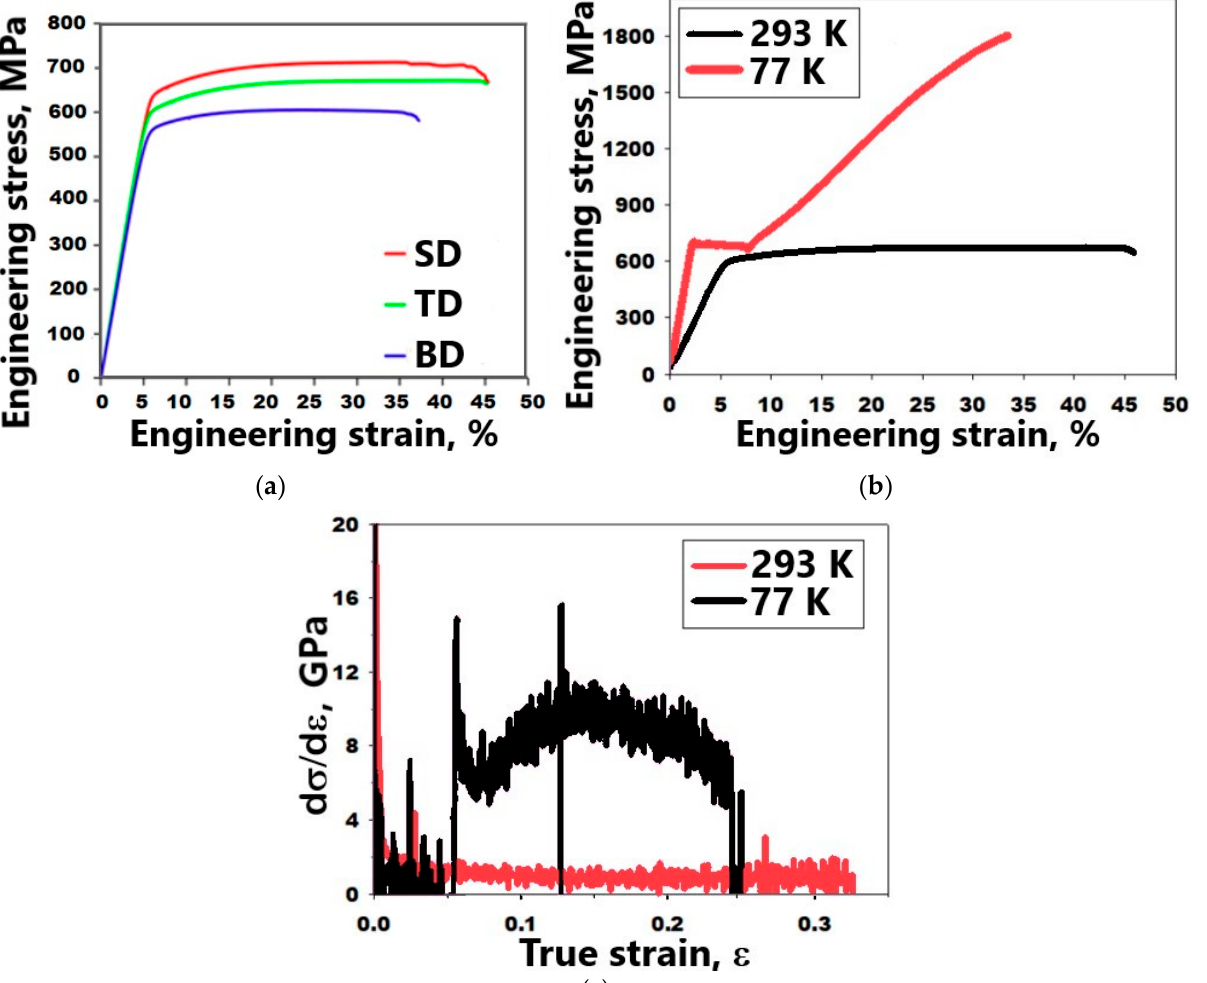
Figure 9. Stress-strain curves obtained during tensile tests at room temperature ( a ); comparison of the mechanical behavior of TD specimens at room and cryogenic temperature: stress-strain curves ( b ) and strain hardening ( c ) of the as-produced (mode: P = 200 W and V = 1600 mm/s) Fe 65 (CoNi) 25 Cr 9.5 C 0.5 alloy. Table 3. Mechanical properties of the as-produced Fe 65 (CoNi) 25 Cr 9.5 C 0.5 alloy.